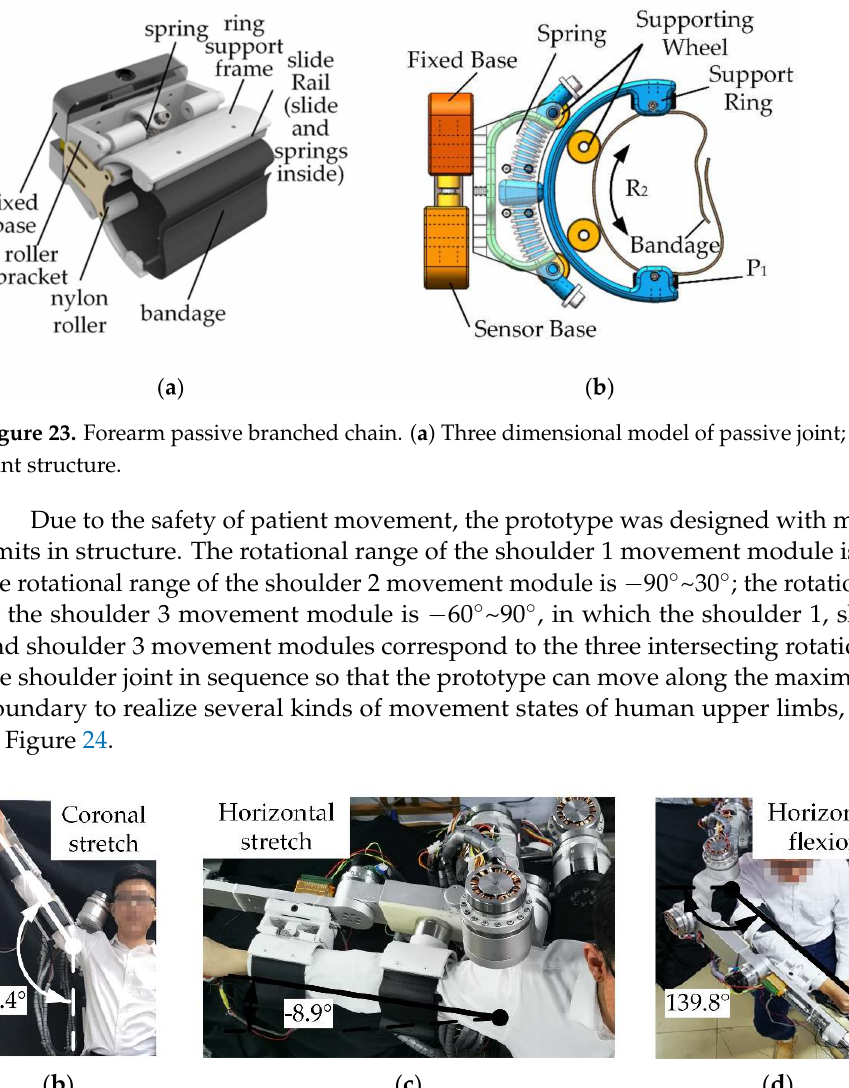
Figure 21. Prototype of 5 R a 1 P configuration.